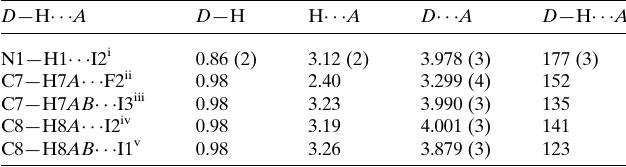
Table 1 Hydrogen-bond geometry (A˚ , (cid:3) ).